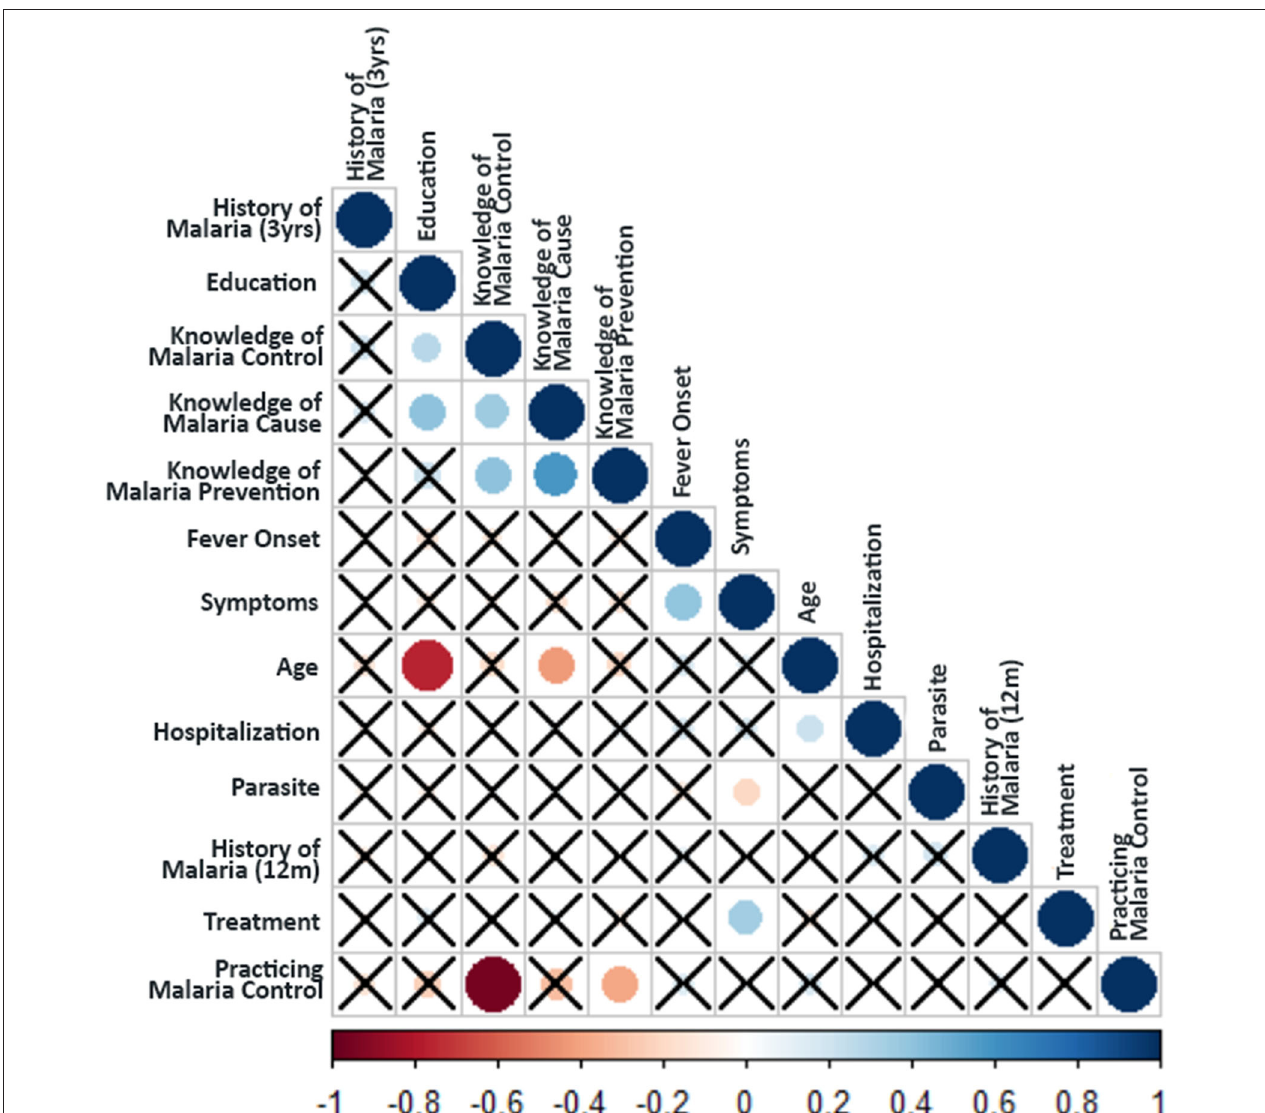
FIGURE 5 | Spearman’s rank Correlation test between the KAP parameters. Crosses indicate no relationship between the variables (i.e., non-significant association p -value > 0.1). The color of circles in the plot indicates the magnitude of the association (as per the scale bar), whereas the size of the circle indicates the significance (larger size indicates higher significance i.e., lower p